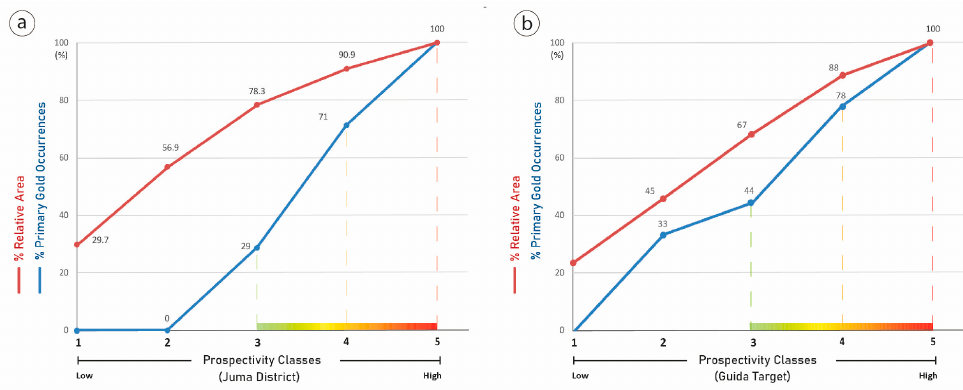
Figure 9 . Relative area and gold occurrence percentages plots for the Juma District and Guida Target. The cumulative percentage of primary gold occurrences (blue line) and the cumulative area (red line) for each prospectivity class (1–5); ( a ) Validation for the Juma District prospectivity map; ( b ) Validation for the Guida Target prospectivity map.